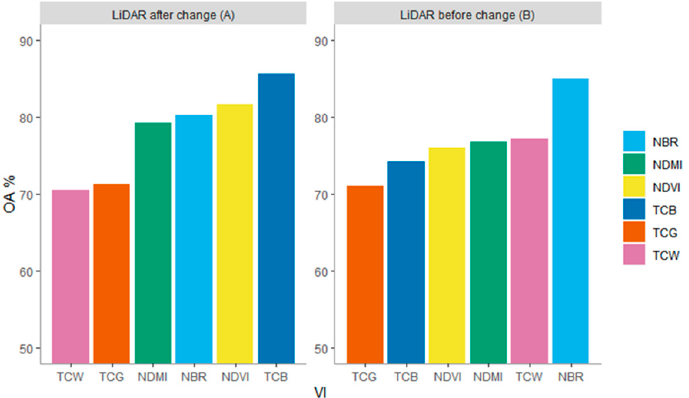
Figure 6. Overall accuracy (OA) results (%) for the detection of different harvesting practices using six VIs (NDVI, NDMI, NBR, TCB, TCG and TCW); ( left ): scenario A , when ALS data were acquired at the end of the monitoring period ; ( right ): scenario B , when ALS data were acquired at the beginning of the monitoring period .